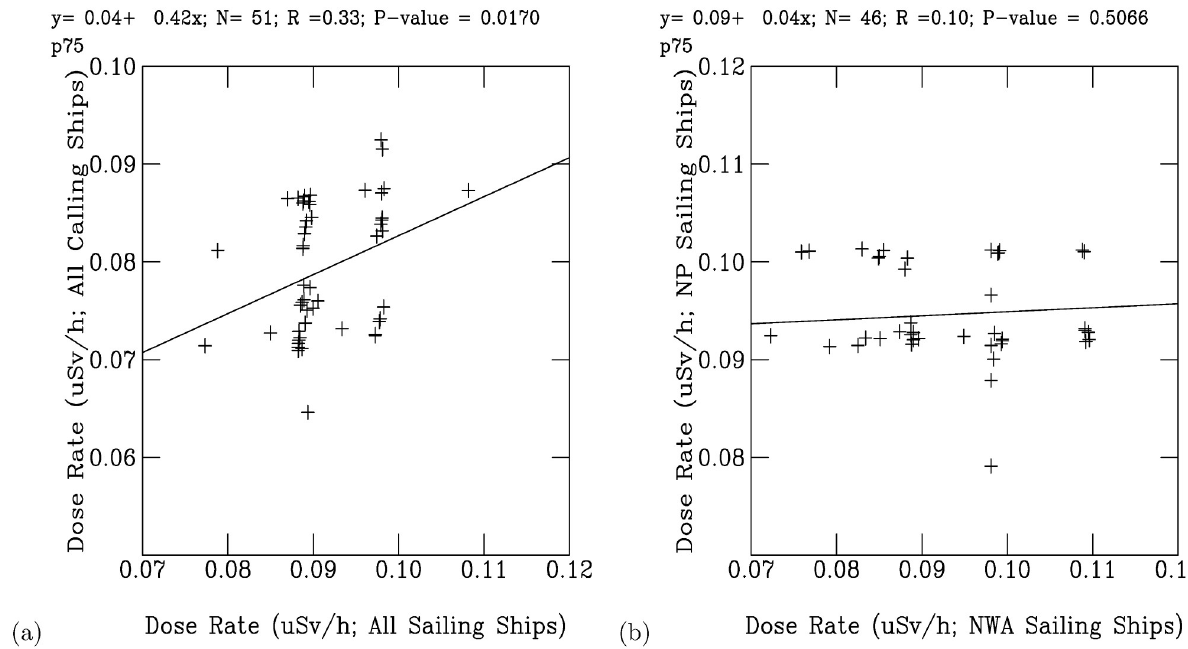
Fig 9. Scatter plot analysis of the monthly 75 th percentile and maximum (b) air dose rates measured on the ships. (a) North Pacific Ocean sailing ships versus Port of Tokyo calling ships. (b) Northwest Atlantic sailing ships versus North Pacific sailing ships.